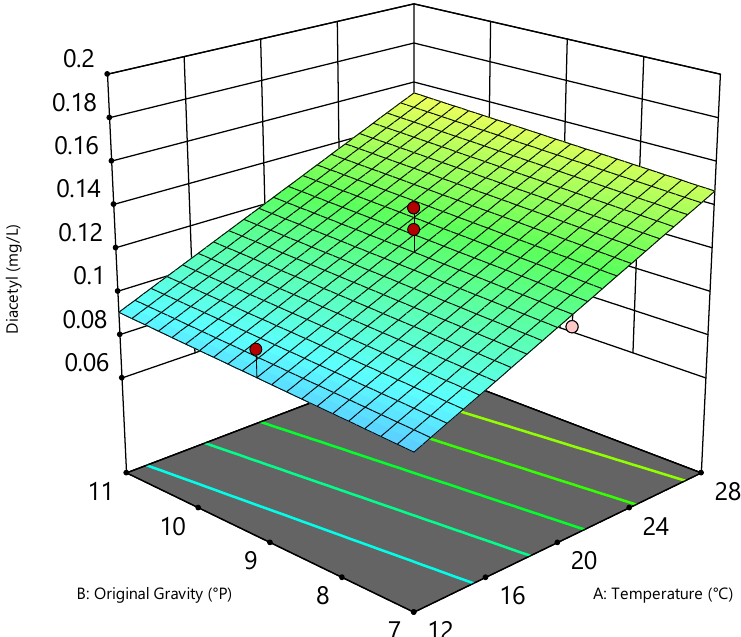
Figure 3. Three-dimensional (3D) diagram of the linear correlation of original gravity (°P), temper- ature (°C), and diacetyl concentration (mg/L) of the beers at a pitching rate of 15 × 10 6 cells/mL. The lower the selected pitching rate, the lower the measurable diacetyl concentration in the beers (cf. Table 5). While the influence of the original gravity was negligible, the fermentation temperature had a decisive influence. The 3D diagram clearly depicts that significantly less diacetyl was formed at a fermentation temperature of 12 °C than at 28 °C.